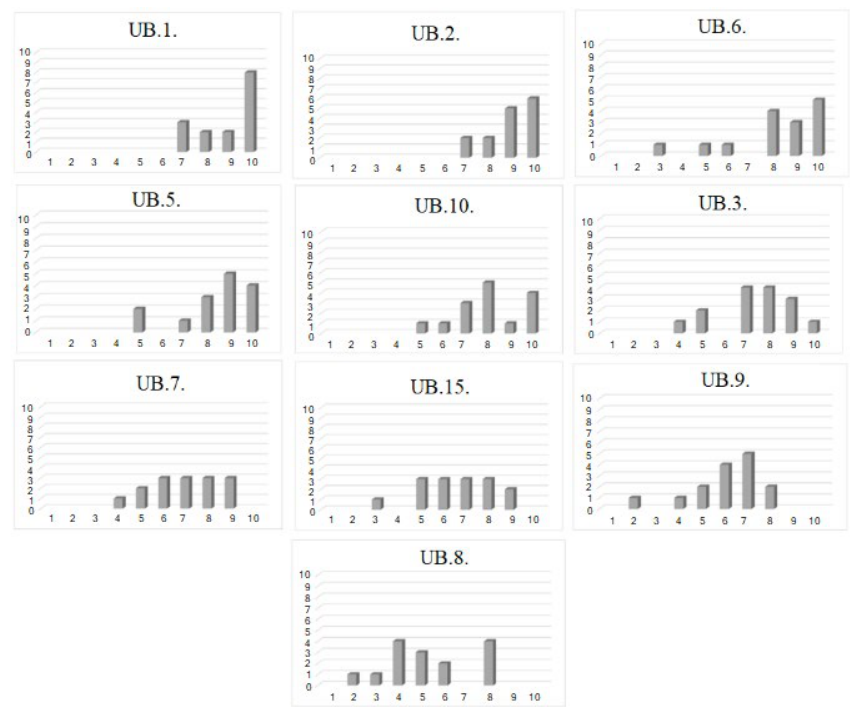
Fig. 2 . Evaluation of the importance of user behaviour (UB)